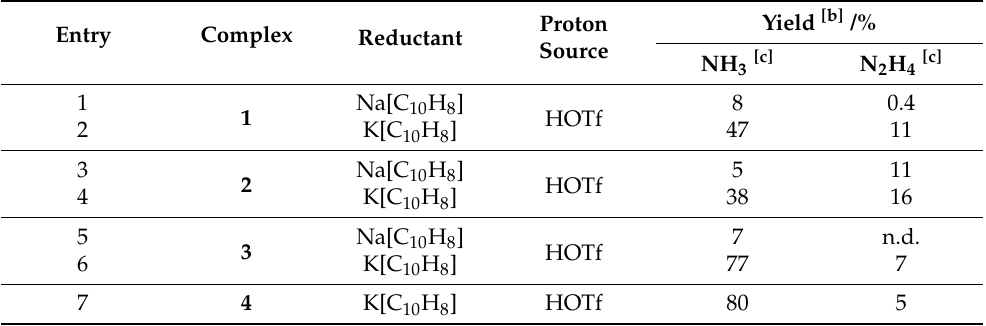
Table 3. Quantification of ammonia and hydrazine produced from the reactions of 1 – 4 with reductants and proton sources [a]